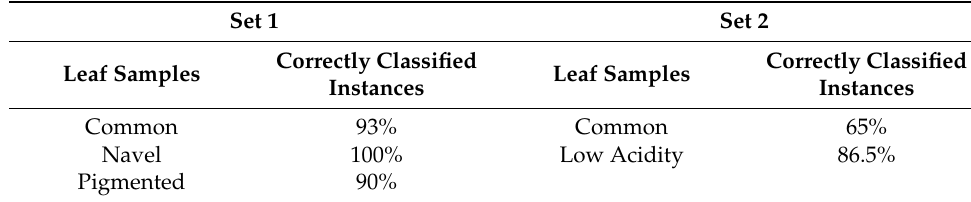
Table 2. Correctly classified instances obtained by constructing an induced classifier based on the calculated peak areas as input